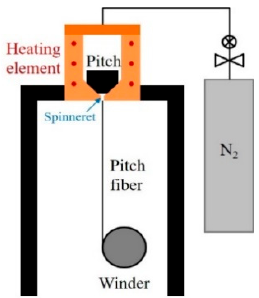
Figure 1. Melt-spinning instrument scheme.